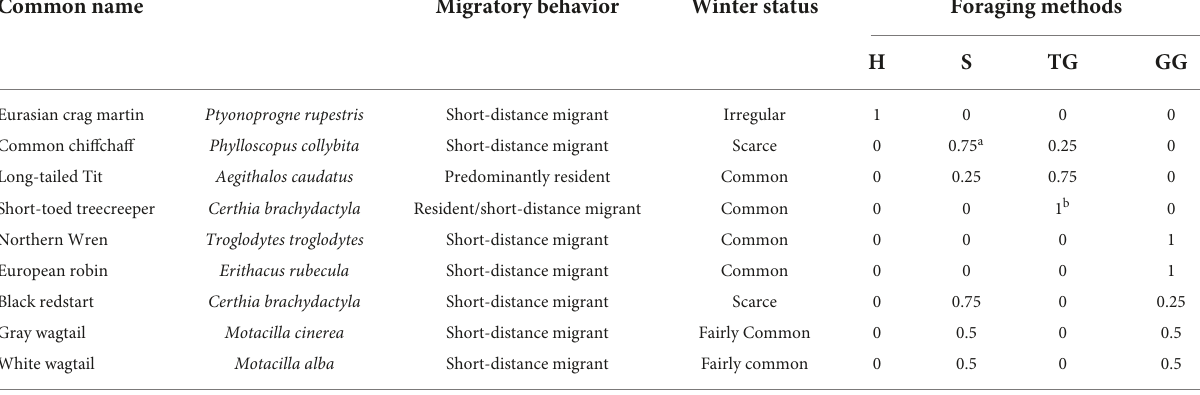
TABLE 1 Characteristics of the guild of insectivorous birds considered in the study.